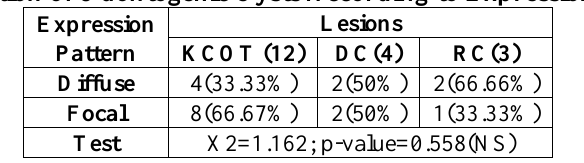
Table 3: Case Distribution of Odontogenic Cysts According to Expression Pattern of Cyclin D1